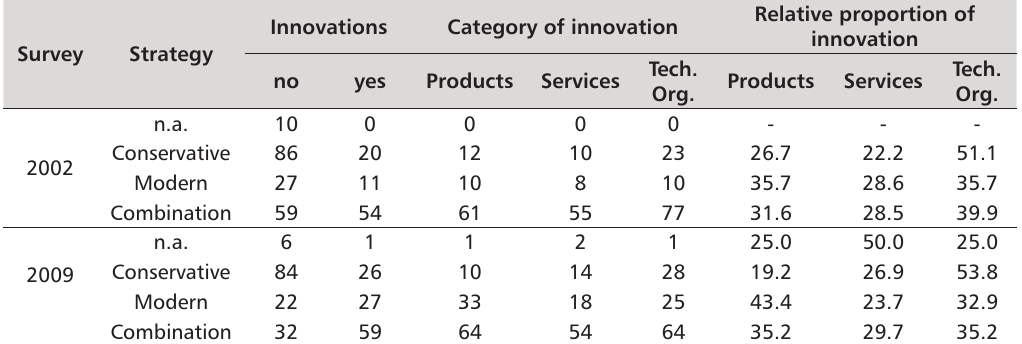
TABLE 6. Management strategy and number of implemented